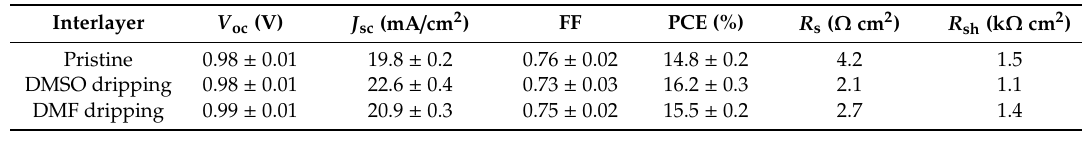
Table 3. Average device parameters of twenty-four perovskite solar cells based on pristine and solvent washing treated PEDOT:PSS layers.